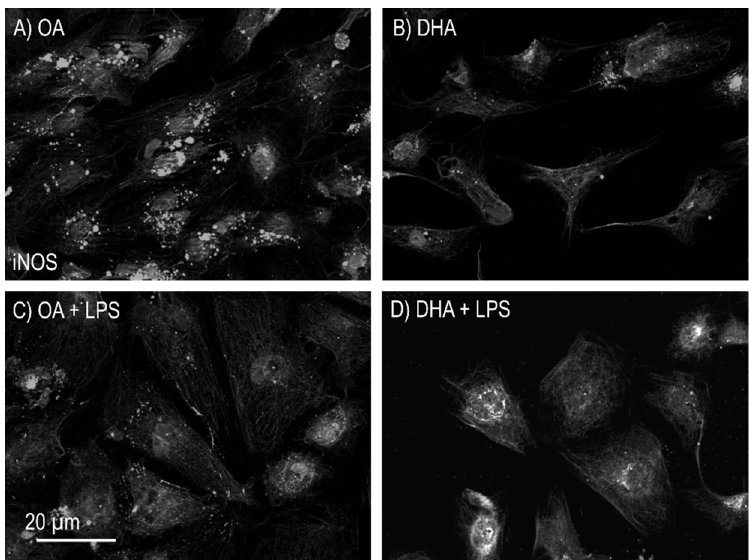
Figure 5. Immunofluorescence detection of inducible nitric oxide synthase (iNOS) in mature Atlantic salmon adipocytes in vitro incubated with oleic (OA) ( A ) or docosahexaenoic acid (DHA) ( B ) for 6 days. Thereafter, the OA group ( C ) and the DHA group ( D ) were exposed to lipopolysaccharide (LPS) for 20 h.